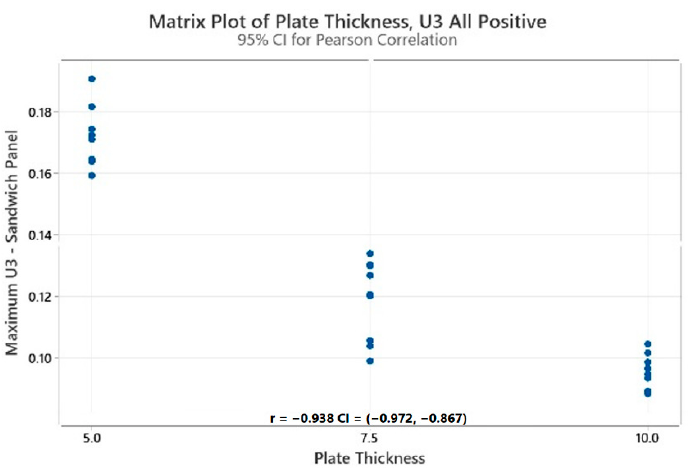
Figure 17. Plate thickness and sandwich panel displacement correlation.